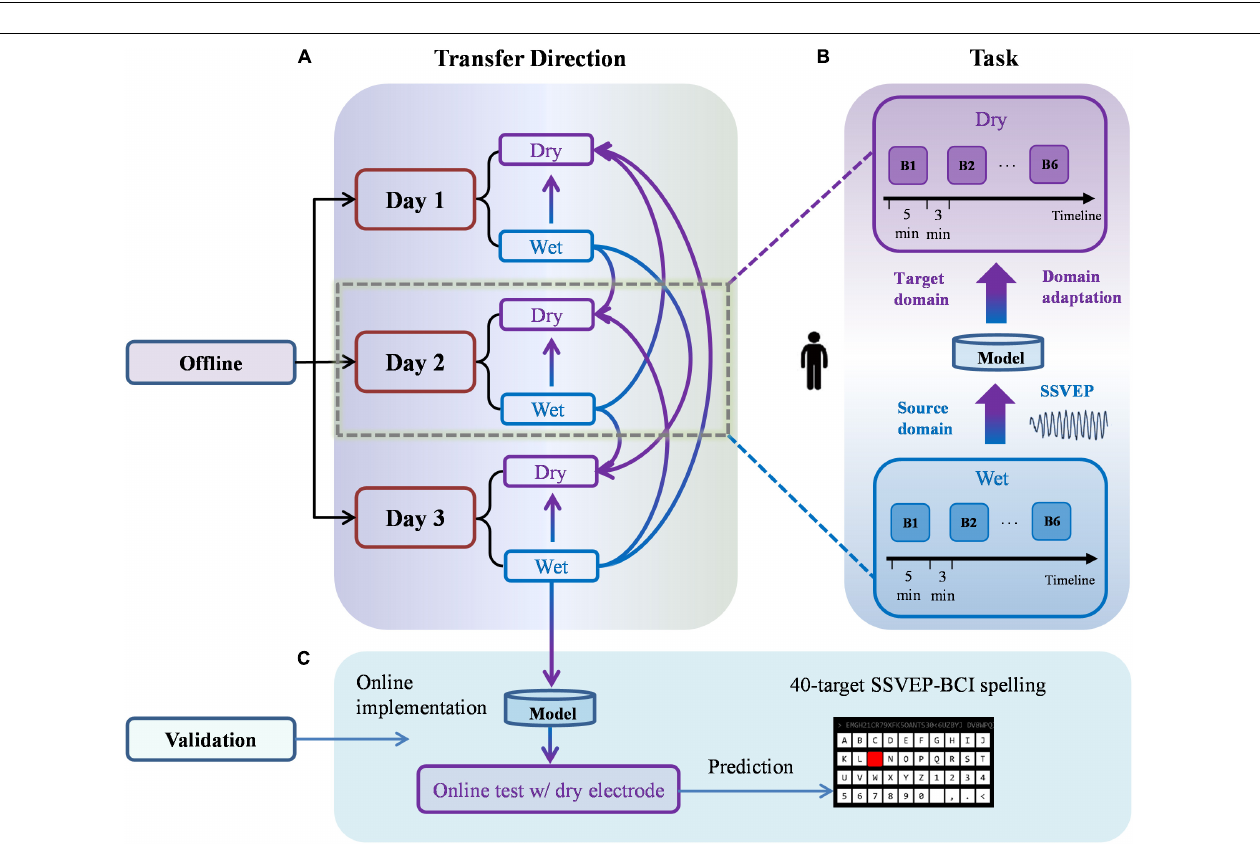
FIGURE 2 | The flowchart of experiments. (A) The within-day wet-to-dry and cross-day wet-to-dry transfers in the offline experiment. (B) Specific tasks and the within-day wet-to-dry transfer in the offline experiment. (C) Block diagram of the validation experiment.